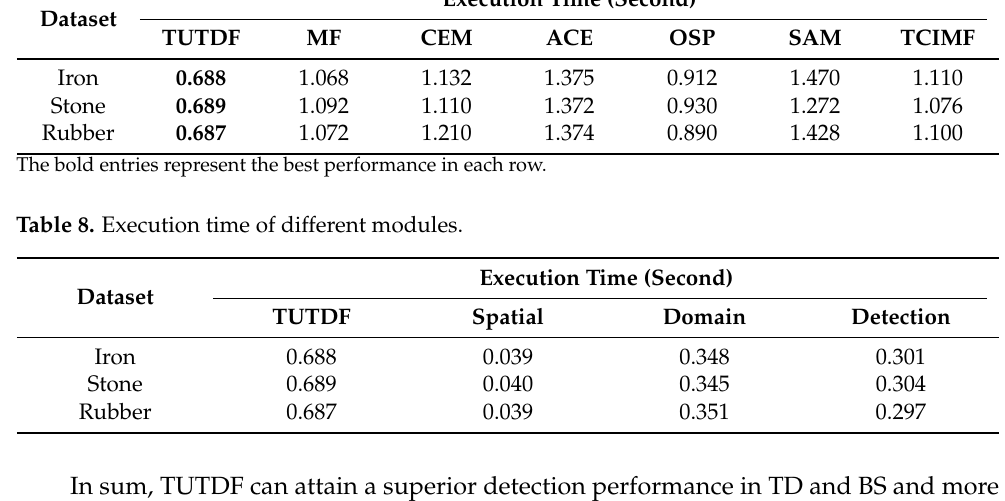
Table 7. Execution time of different methods. Dataset